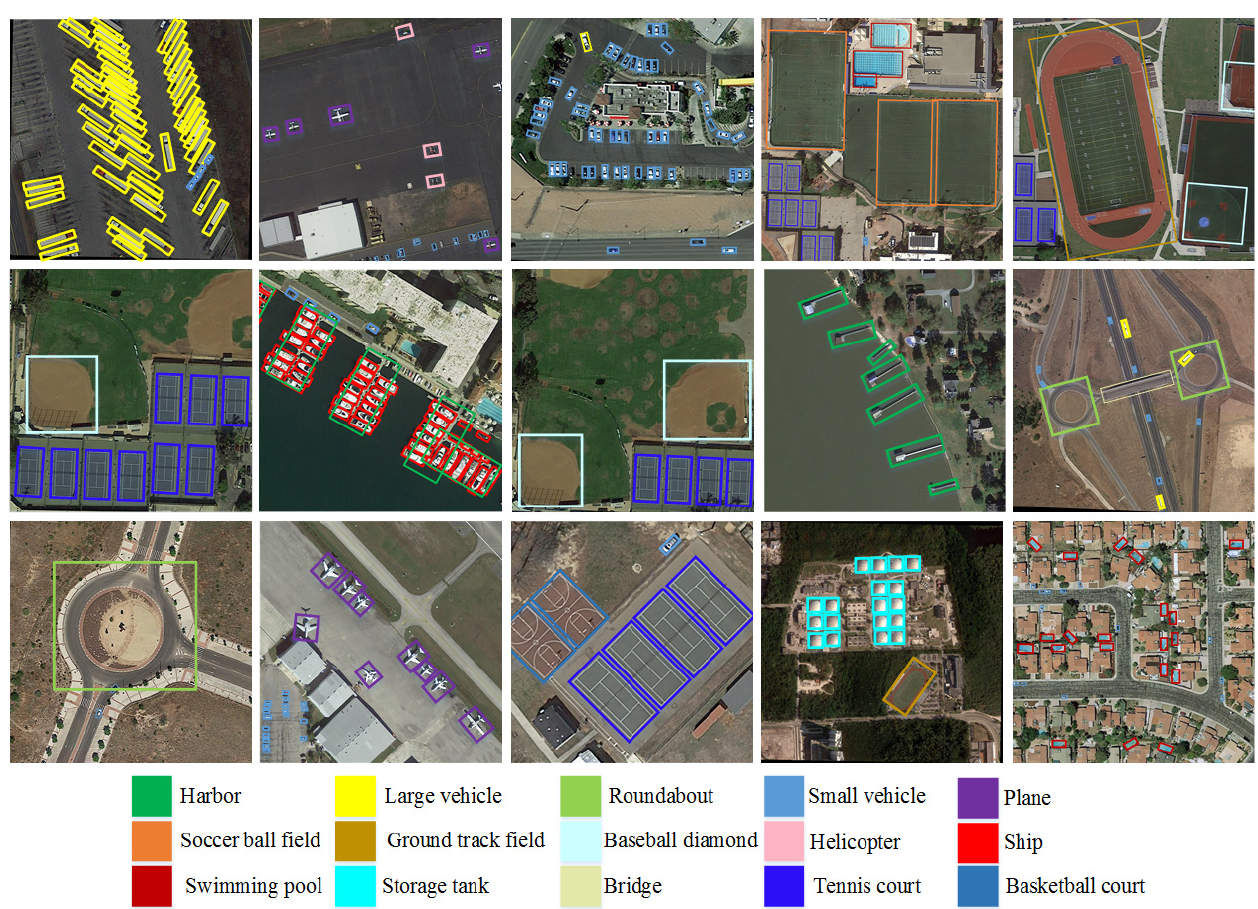
Figure 7. Visualization of the detection results of our method on the DOTA data set.